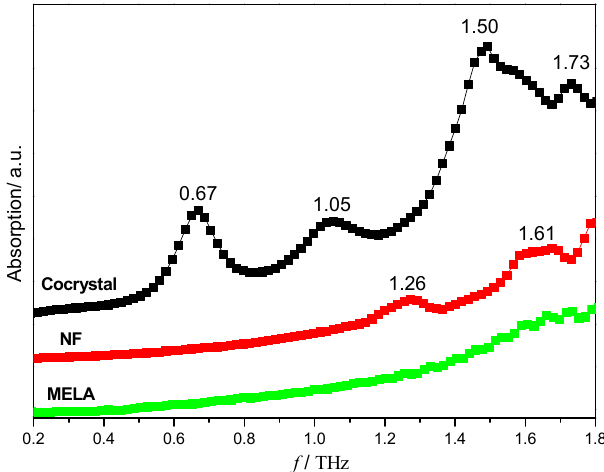
Figure 3. THz absorption spectra of NF, MELA and their hydrated co-crystal.